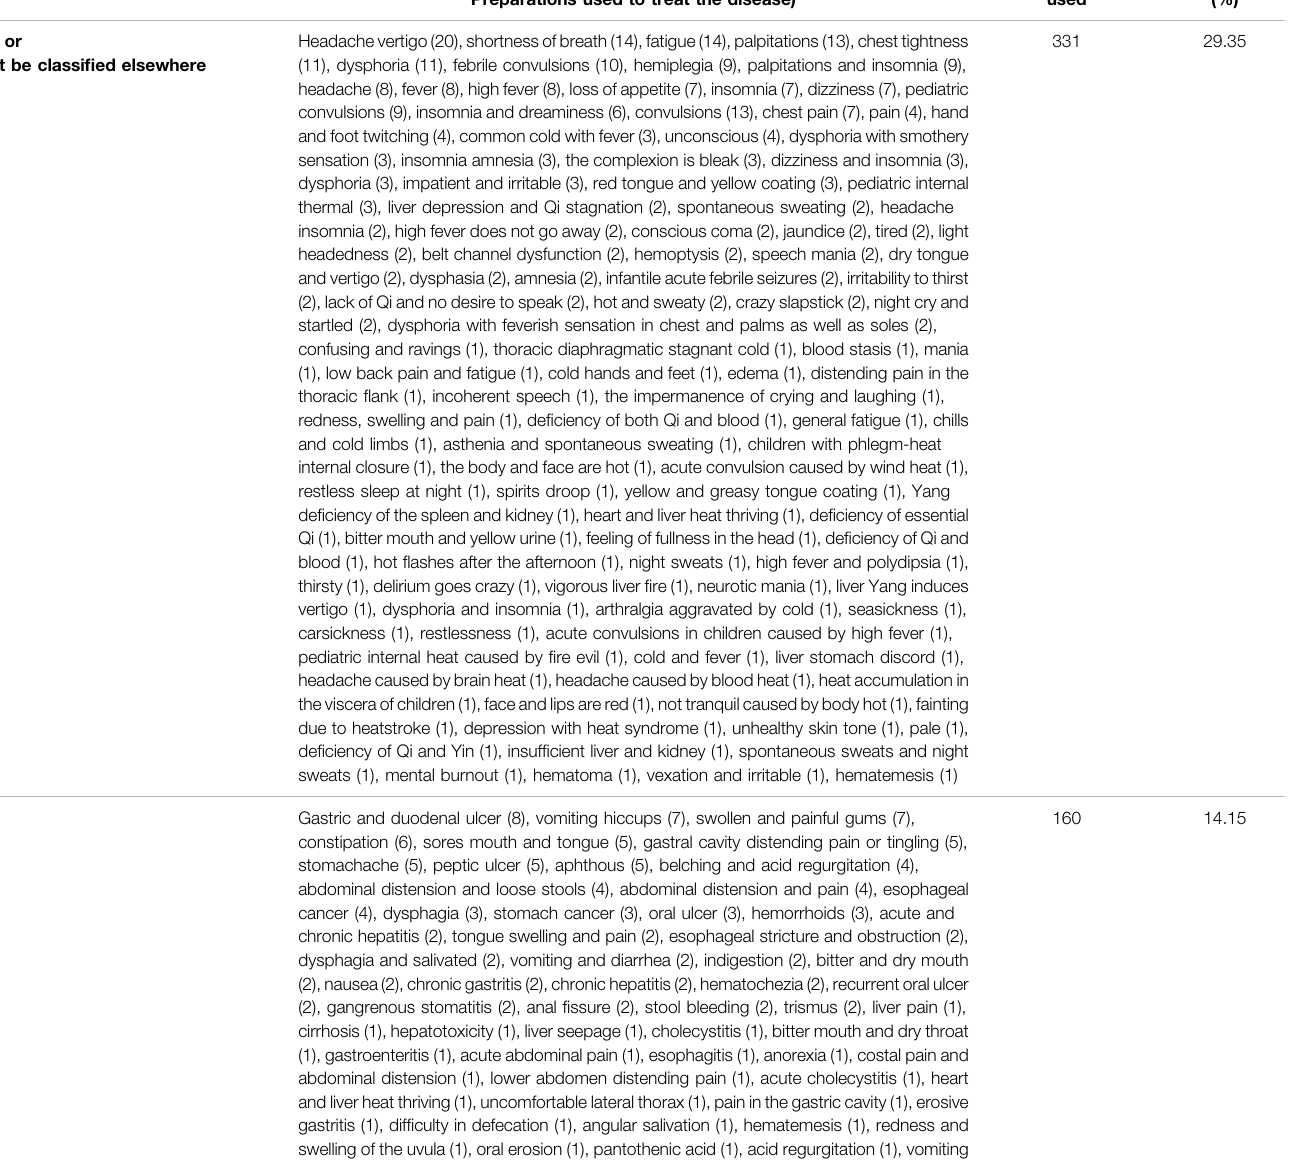
TABLE 4 | Classi fi cation statistics table for the indications of preparations containing